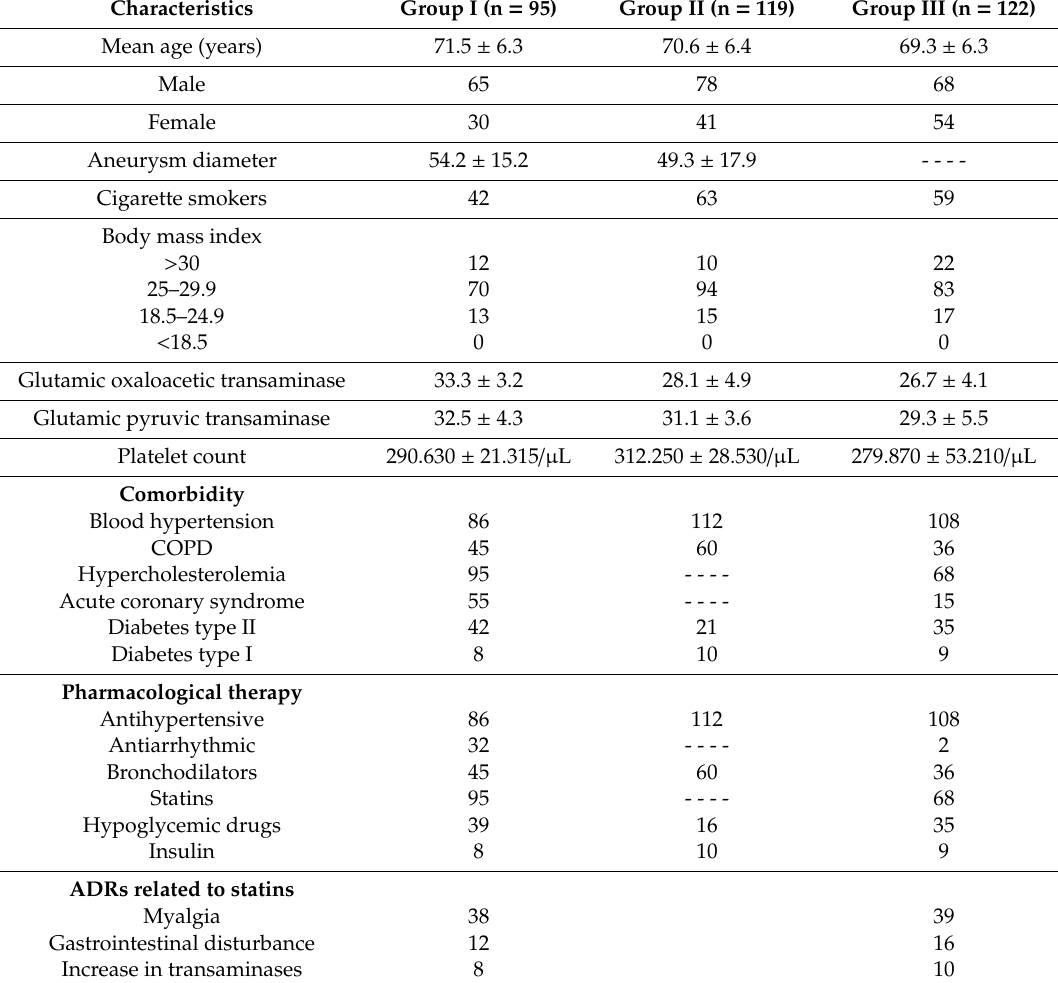
Table 1. Enrolled patients in Group I (statin-treated), Group II (statin-free), and Group III (without aneurysm, taking statins, defined control group). Data are expressed as absolute values or as mean ± standard